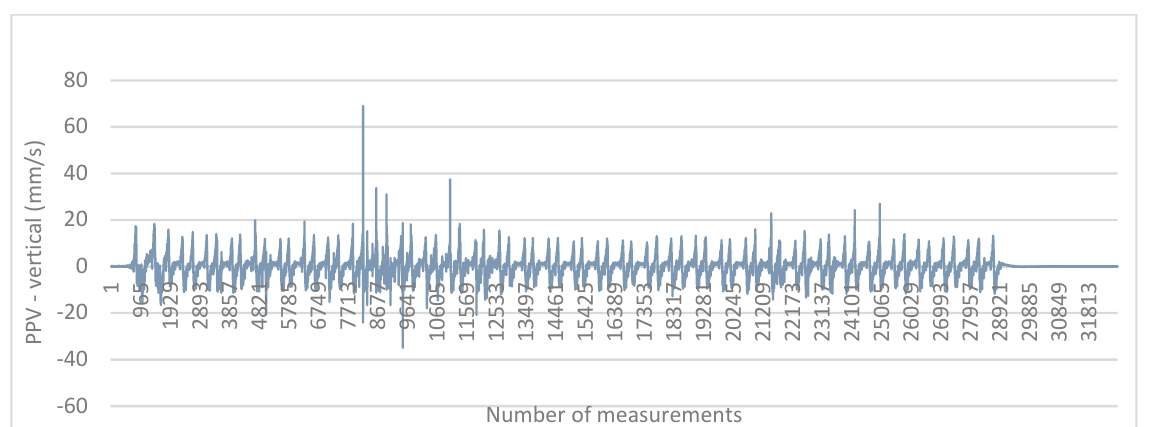
Figure 3. Results of vibration velocity measurements with the Minimate Plus seismograph for a passenger train in motion, where PPV—vertical is the vertical component of the vibration velocity and the number of vibration measurements is the number of measurements recorded over a period of 5.75 s.